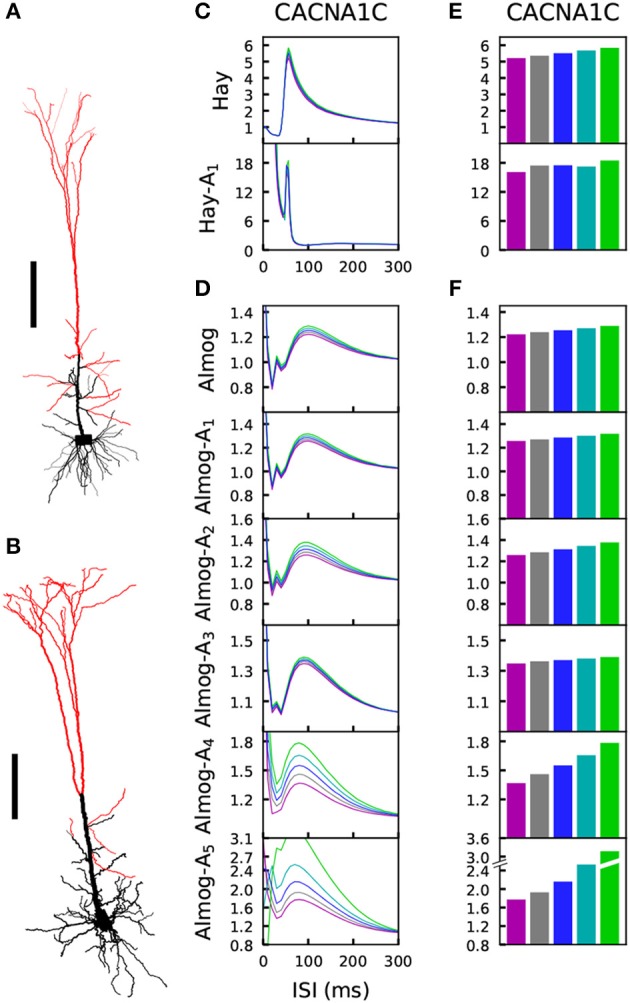
The L5PC adaptation by a prepulse is altered by variants of HVA Ca2+ channels. (A,B) Illustration of the morphologies of the two models. The model neurons of Hay (A) and Almog (B) were given stimulation through 3,000 conductance-based synapses that were uniformly distributed along the apical dendrites, except for the most proximal compartments whose distance from the soma were less than 300 (A) or 450 (B) μm. Scale bar 200 μm. (C,D) The synapses of the Hay (C) or Almog (D) model neuron were activated two times, first at the time instant t = 0 with an alpha-shaped (time constant 5 ms) conductance whose maximal amplitude was 10% higher than that needed for inducing a spike, and later after an ISI displayed on the x-axis. The y-axis shows the threshold conductance factor with which the neuron fired an additional action potential—thus, at the limit of large ISI the curves converge to 1, which represents the threshold conductance at rest. The blue curve represents the control neuron, while the other colors represent the data corresponding to the different downscaled versions of the CACNA1C variant of Figure 2. (E,F) The maximal threshold conductance factor from the curves of (C) and (D), excluding the first 40 ms. Colors as in Figure 2.